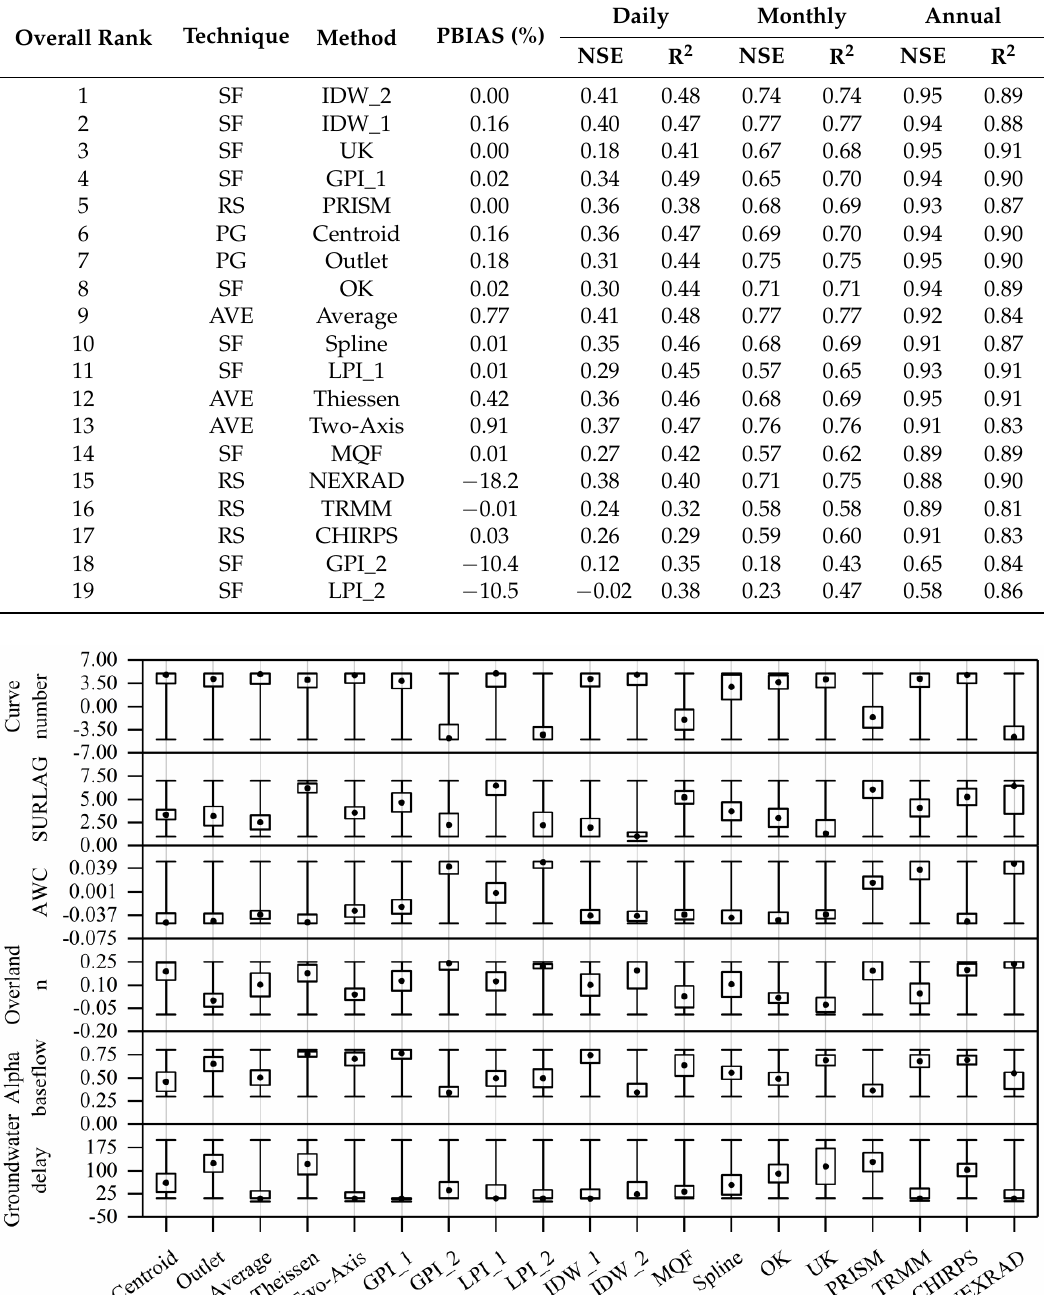
Table 8. Mean areal precipitation (MAP) input effects on the calibrated SWAT model performance results and ratings at daily, monthly, and annual time steps after the SWAT model calibration in the Hinkson Creek Watershed, Missouri, USA. SWAT models were forced with 19 different precipitation methods. MAP methods are presented by the overall model performance rank (i.e., high to low rank).